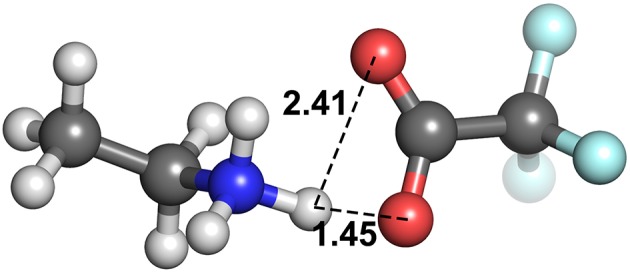
The two hydrogen bonds in [EtNH3][TFA](CPCMoptimized).